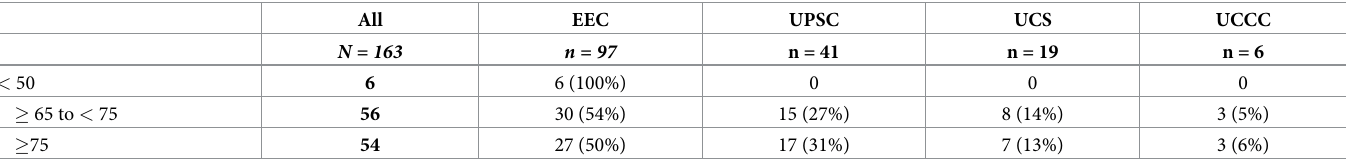
Table 2. Distribution of endometrial cancers (ECs) according to age groups (years). All EEC